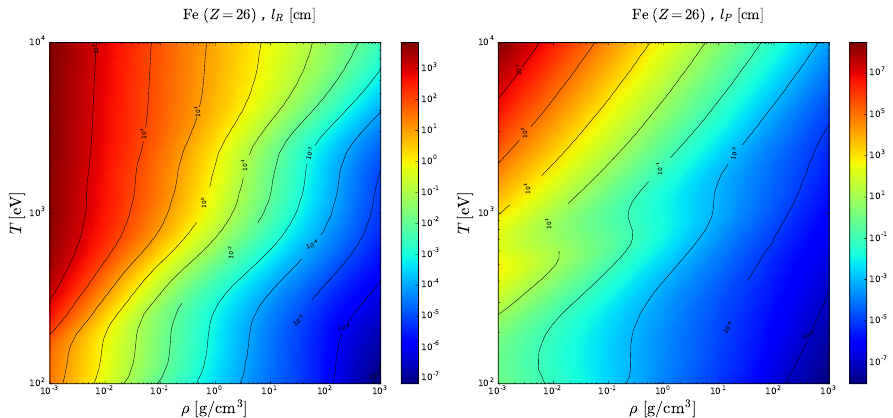
Figure 5. Maps on the temperature-density plane of the Rosseland (left pane) and Planck (right pane) photon absorption mean free